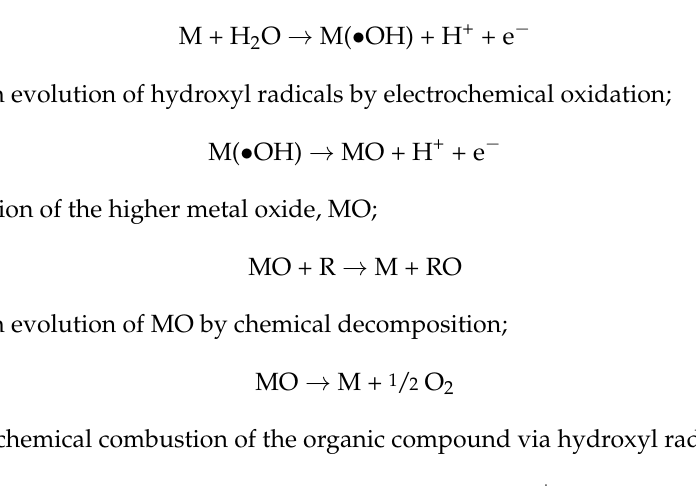
Figure 10. Schematic of electrochemical oxidation of organics by activated chlorine. Reproduced from Ref. [56]. Copyright 2006 Royal Society of Chemistry. Saratale et al. [62] studied the electrochemical oxidation of phenol in wastewater us- ing Ti/PbO 2 as an electrode. The Ti/PbO 2 electrode included PbO 2 coated on Ti prepared by the electrodeposition method. Experiments have focused on the optimization of vari- ous parameters such as current density, initial concentration of phenol, initial pH of the solution, temperature, and dose of Fe 2+ on the electrochemical degradation of phenol us- ing Ti/PbO 2 . As a result, the complete removal of phenol (250 mg/L) was observed at a temperature of 50 °C, with potential differences of 5 V, and at pH 2 after 9 h. Table 7 shows the comparison of phenol degradation using different types of electrodes via the electro- chemical oxidation process.